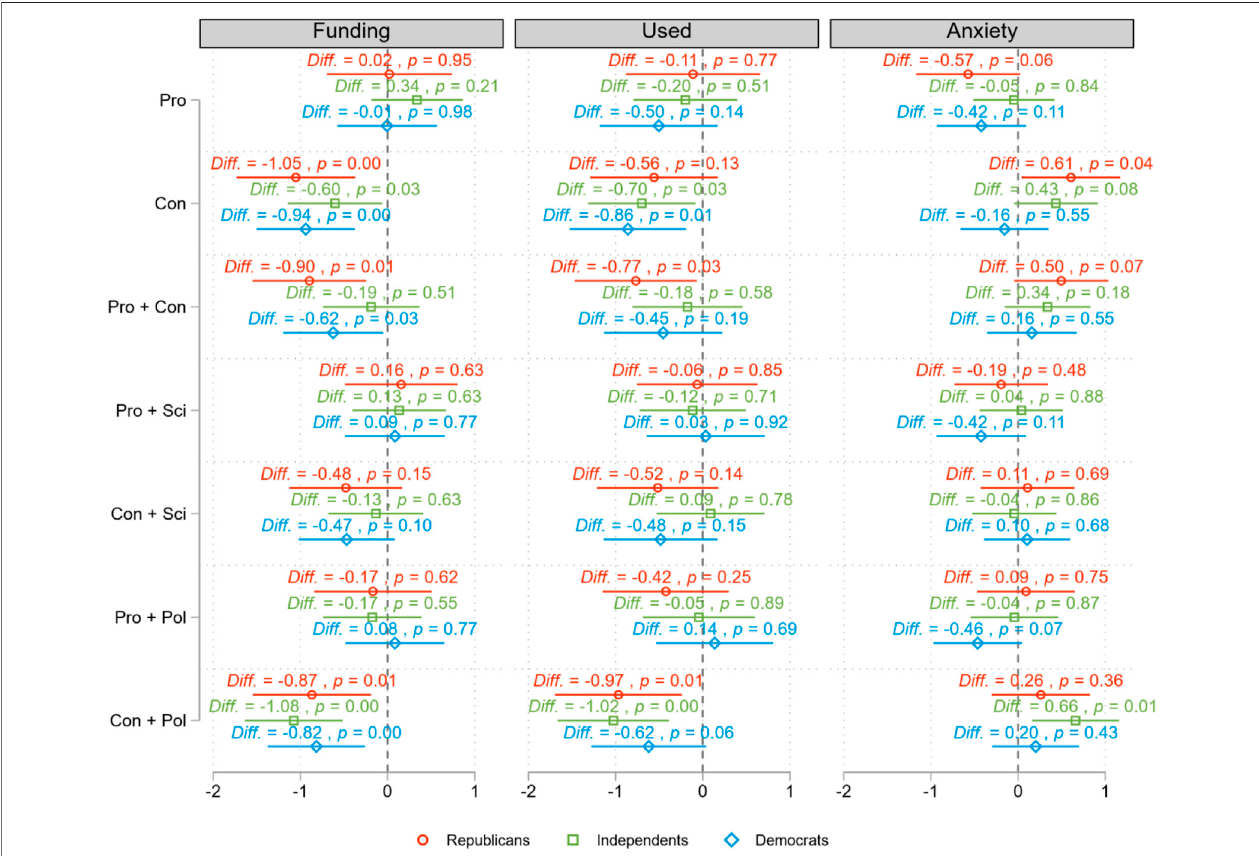
FIGURE 1 | Treatment Effects Across Party Subgroups. Dots are coef fi cient estimates with error bars representing the 95% con fi dence interval. Models restricted toRepublicansonly,Independentsonly,andDemocratsonlyarecoloredinred,green,andblue,respectively.Allrestrictedmodelsuseco-partisansintheControlgroup as the reference category. All signi fi cance estimates are from two-tailed tests. A complete table of results is available in the Appendix.